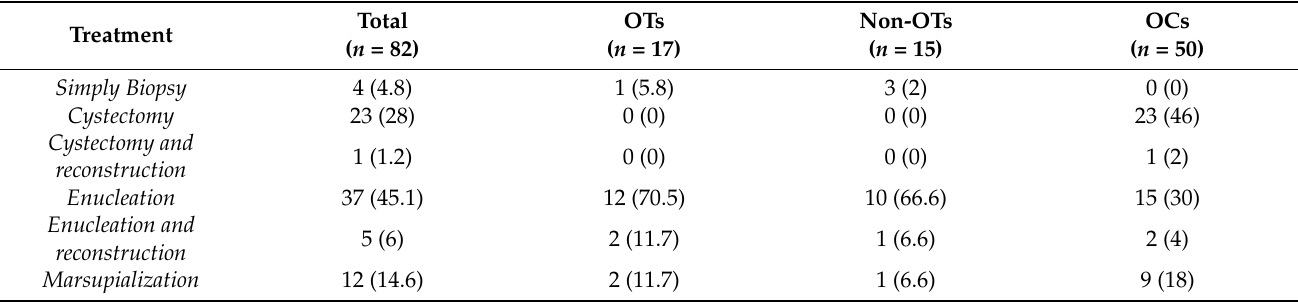
Table 5. Treatment of pediatric jawbone